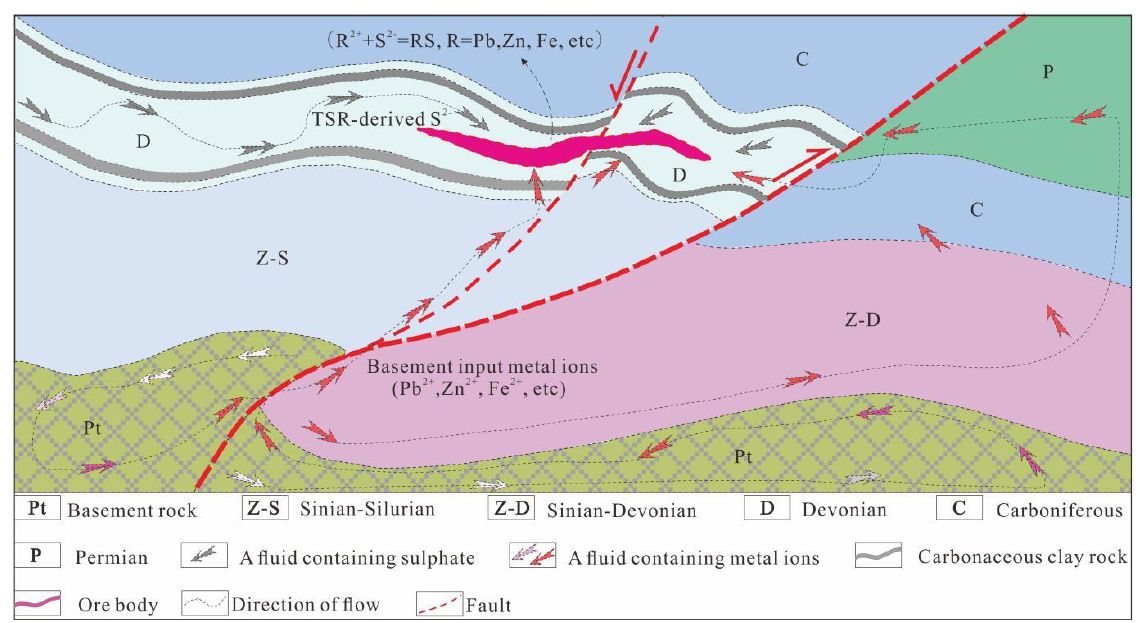
Figure 11. Metallogenic model map of Lekai Pb-Zn deposit [76].